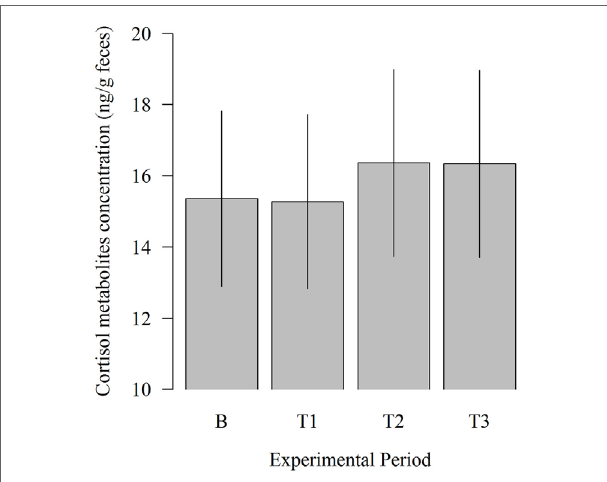
FigUre 5 | effects of the robot scraper on the fecal cortisol metabolites concentration of dairy cows for the baseline measurement (B) and test measurements (T1, T2, T3) . Vertical lines indicate SEMs and asterisks significant differences between means of